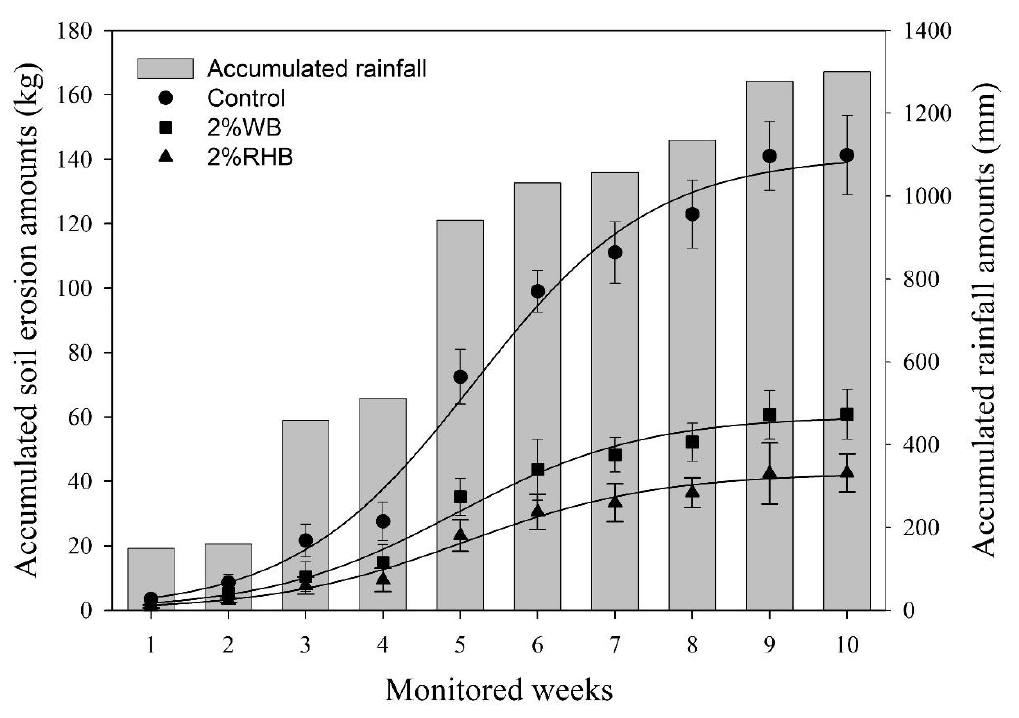
Figure 5. Total rainfall and collected sediment under each treatment from July to October 2018.